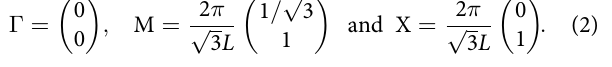
Frontiers in Materials |